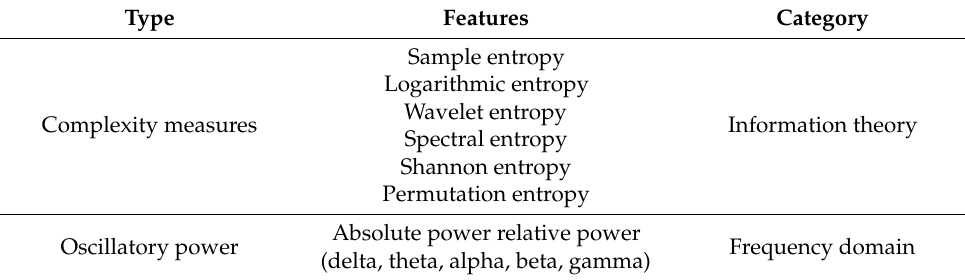
Table 2. Subset of features in correspondence to their